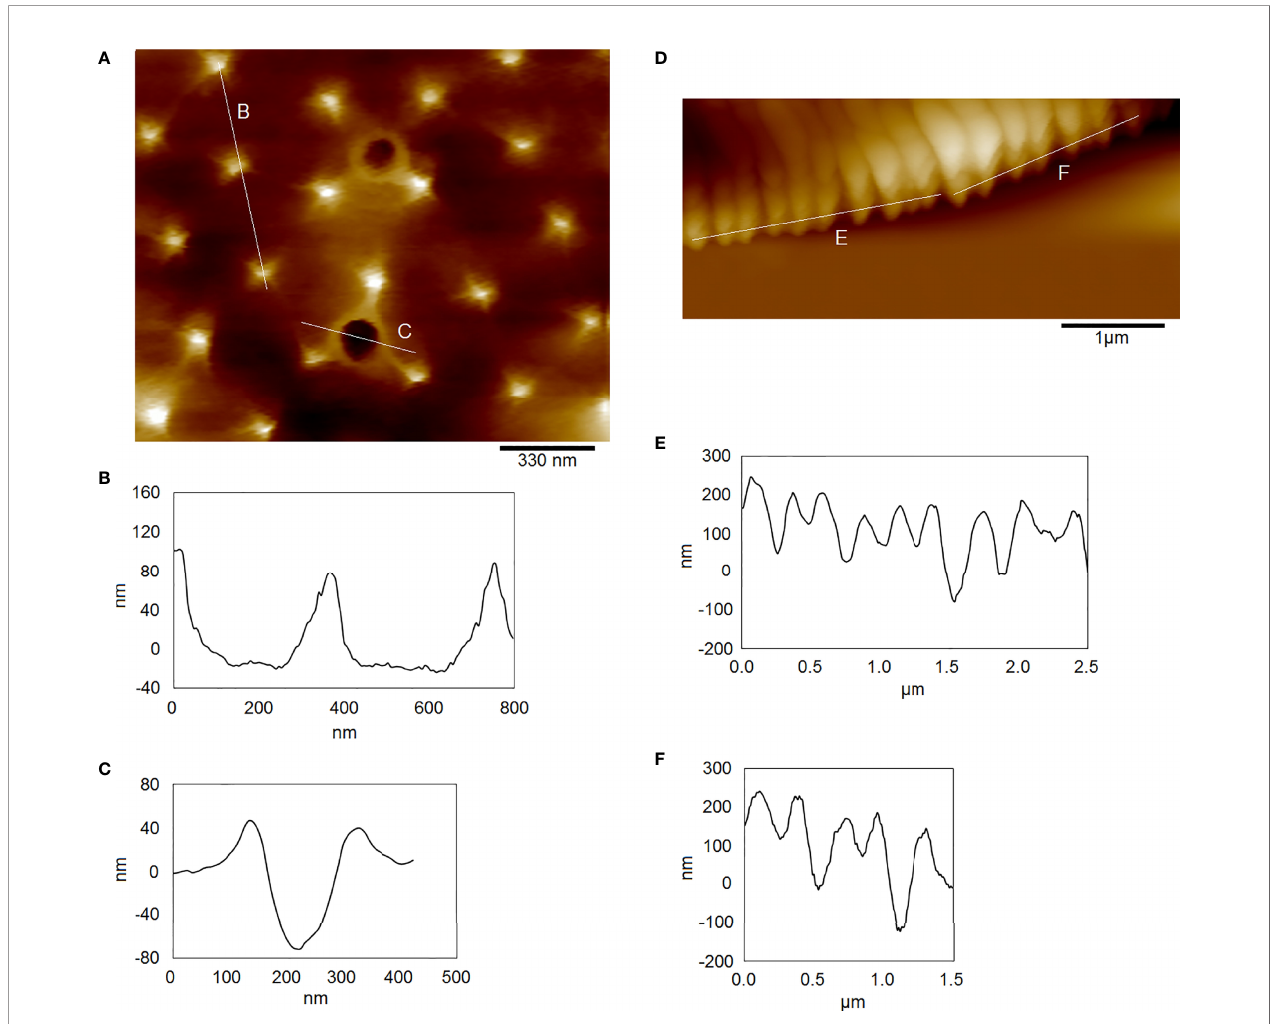
FIGURE 2 | Nanostructure of P. donghaiense . (A) The ultrastructure of the cell surface. (B) The height and spacing value of knob-like spines in Panel A . (C) The height and spacing of valve pores on the shell surface in Panel A. (D) The megacytic zone structure of the cell. (E, F) The surface concave convex value in Panel D